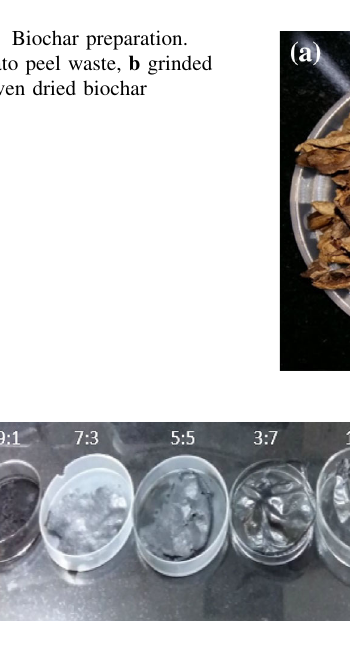
Fig. 2 Prepared membranes of chitosan-modified biochar with varying proportions of